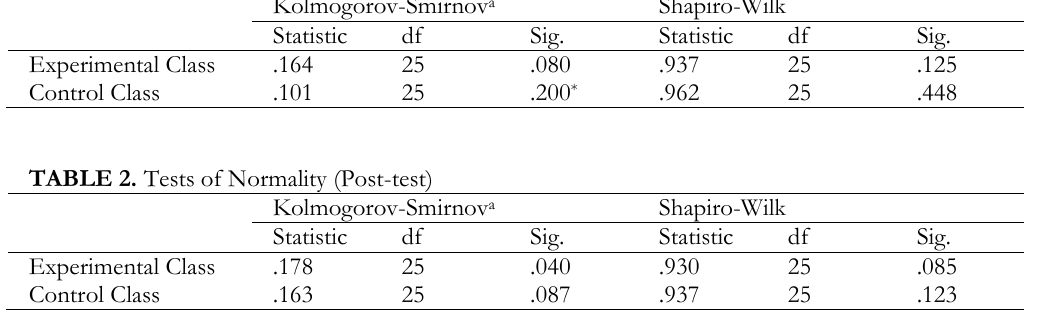
TABLE 3. Test of Homogeneity of